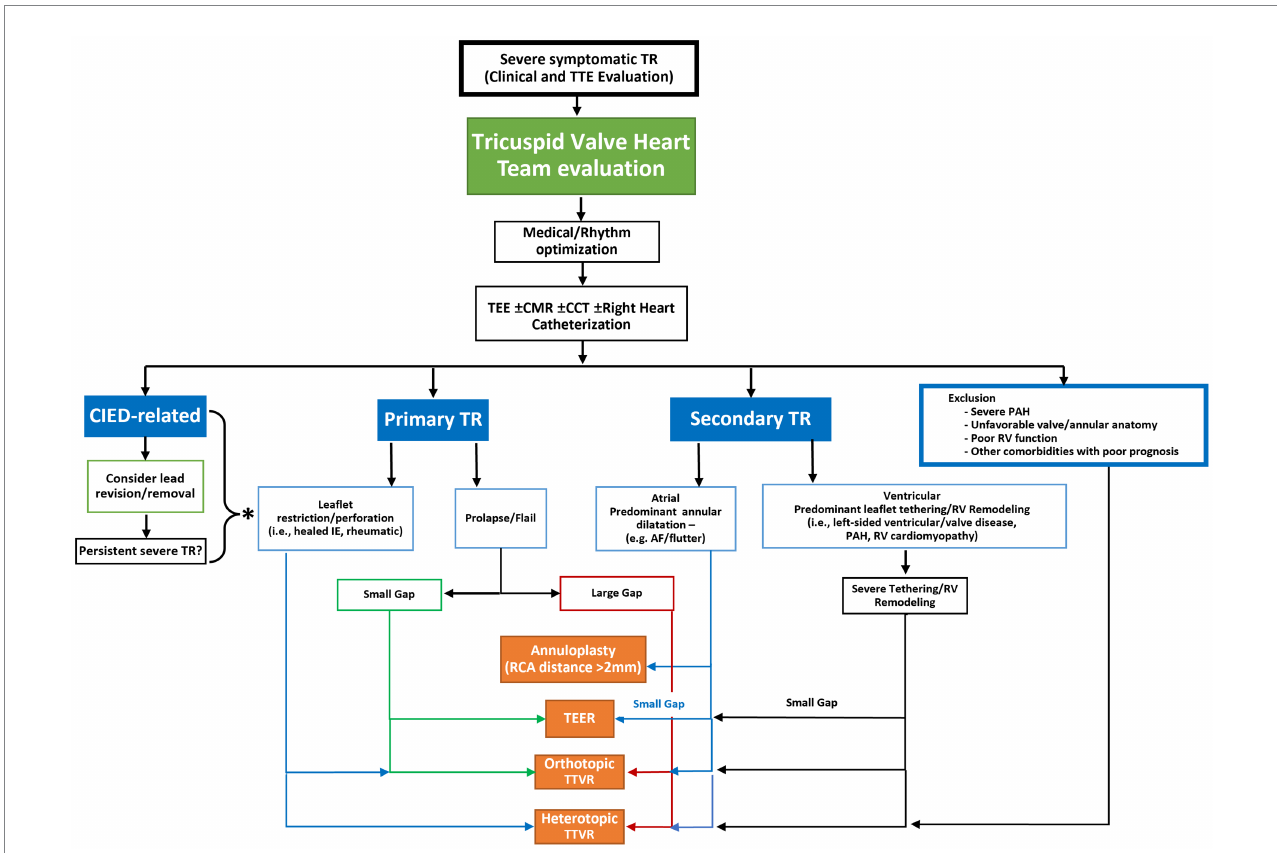
FIGURE 3 Proposed anatomic algorithm for the selection of transcatheter tricuspid valve intervention systems. Following a determination of the presence of severe, symptomatic tricuspid regurgitation (TR), the patient should be referred to a heart team with experience in management of TR. Patients should be medically optimized which may entail rhythm management. If TR persists, then a more comprehensive imaging or invasive assessment may be required to determine the etiology and morphology of the disease. Once this is determined the anatomic characteristics of the disease may determine the most appropriate transcatheter therapy. *If severe TR persists after lead removal, or the TR is not caused by the cardiac implantable electronic device (CIED) then the etiology of the TR should be assessed to determine the possible device choices. CCT, cardiac computed tomography; CIED: cardiac implantable electronic device; CMR, cardiac magnetic resonance imaging; IE, infective endocarditis; MDT, multidisciplinary team; PAH, pulmonary arterial hypertension; RCA, right coronary artery; TEE, transesophageal echocardiography; TEER, transcatheter edge-to-edge repair; TR, tricuspid regurgitation; TTVR, transcatheter tricuspid valve